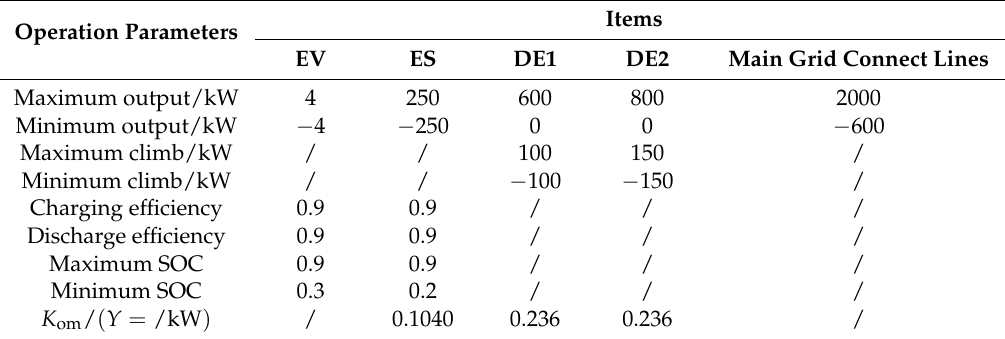
Table A1. Operating parameters.